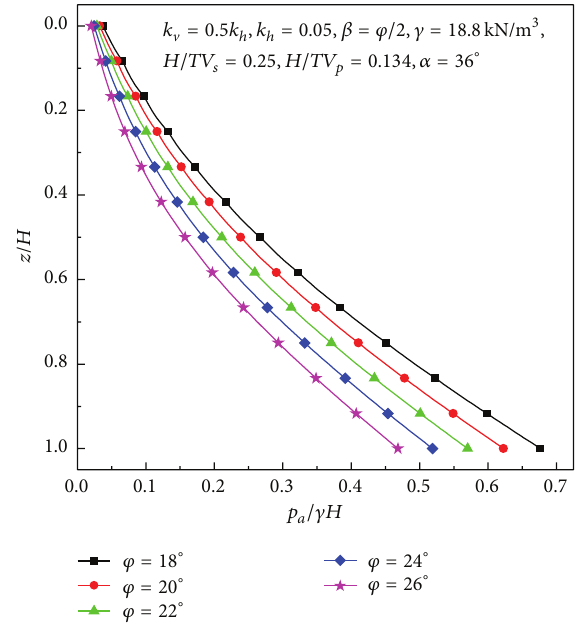
Figure 8: Active earth pressure distribution for different values of soil friction angle, 𝜑